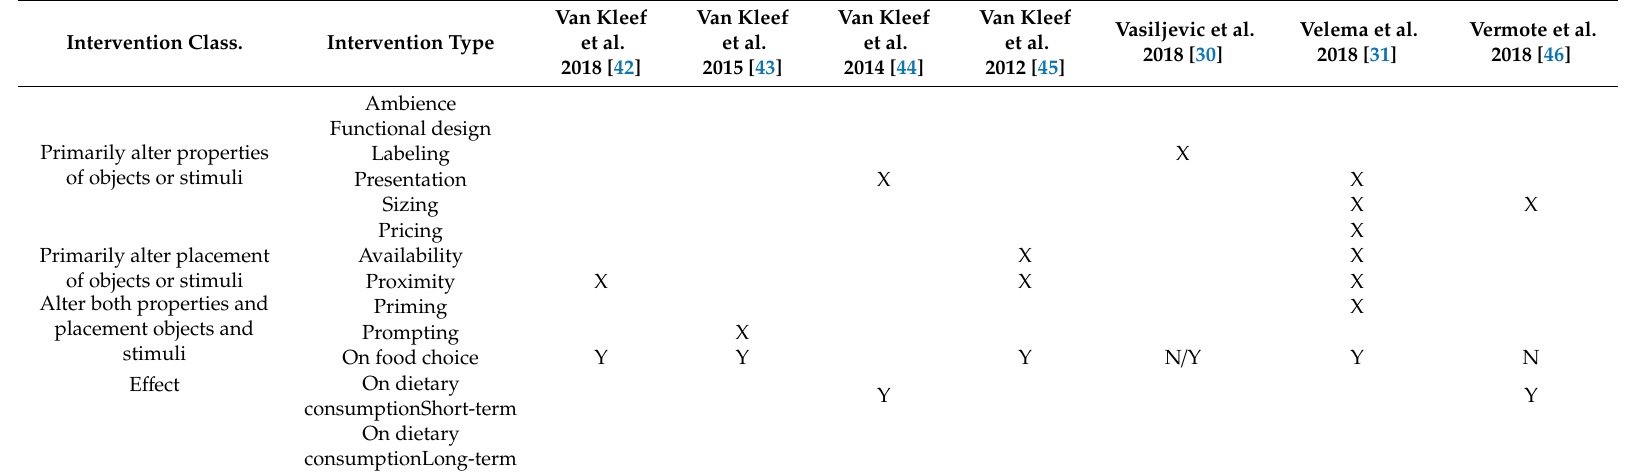
Table 6. Nudging and choice architecture types and e ff ectiveness examined in the included studies. Intervention